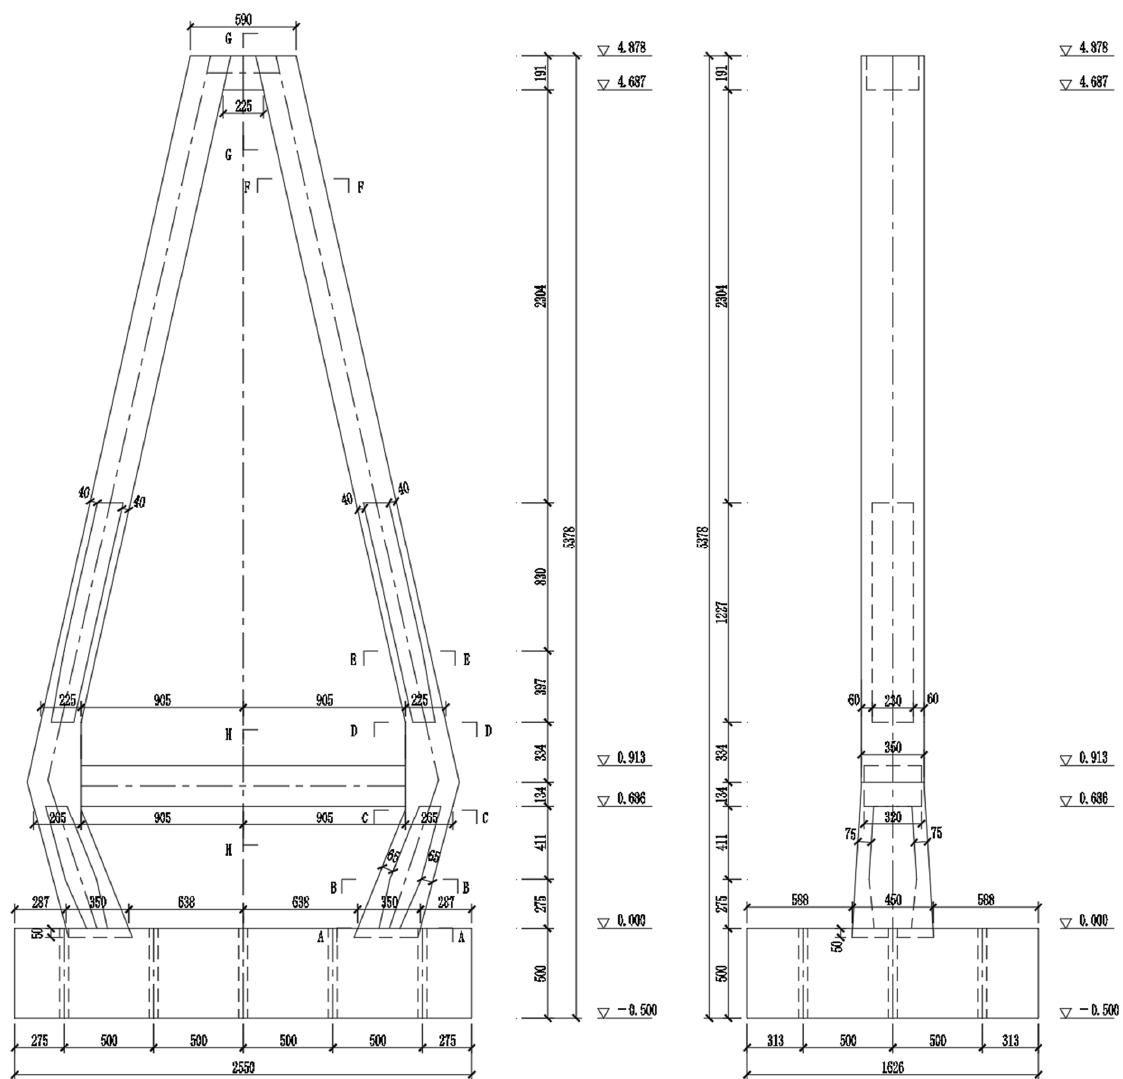
Figure A3. Tower design of bridge model (unit: mm).